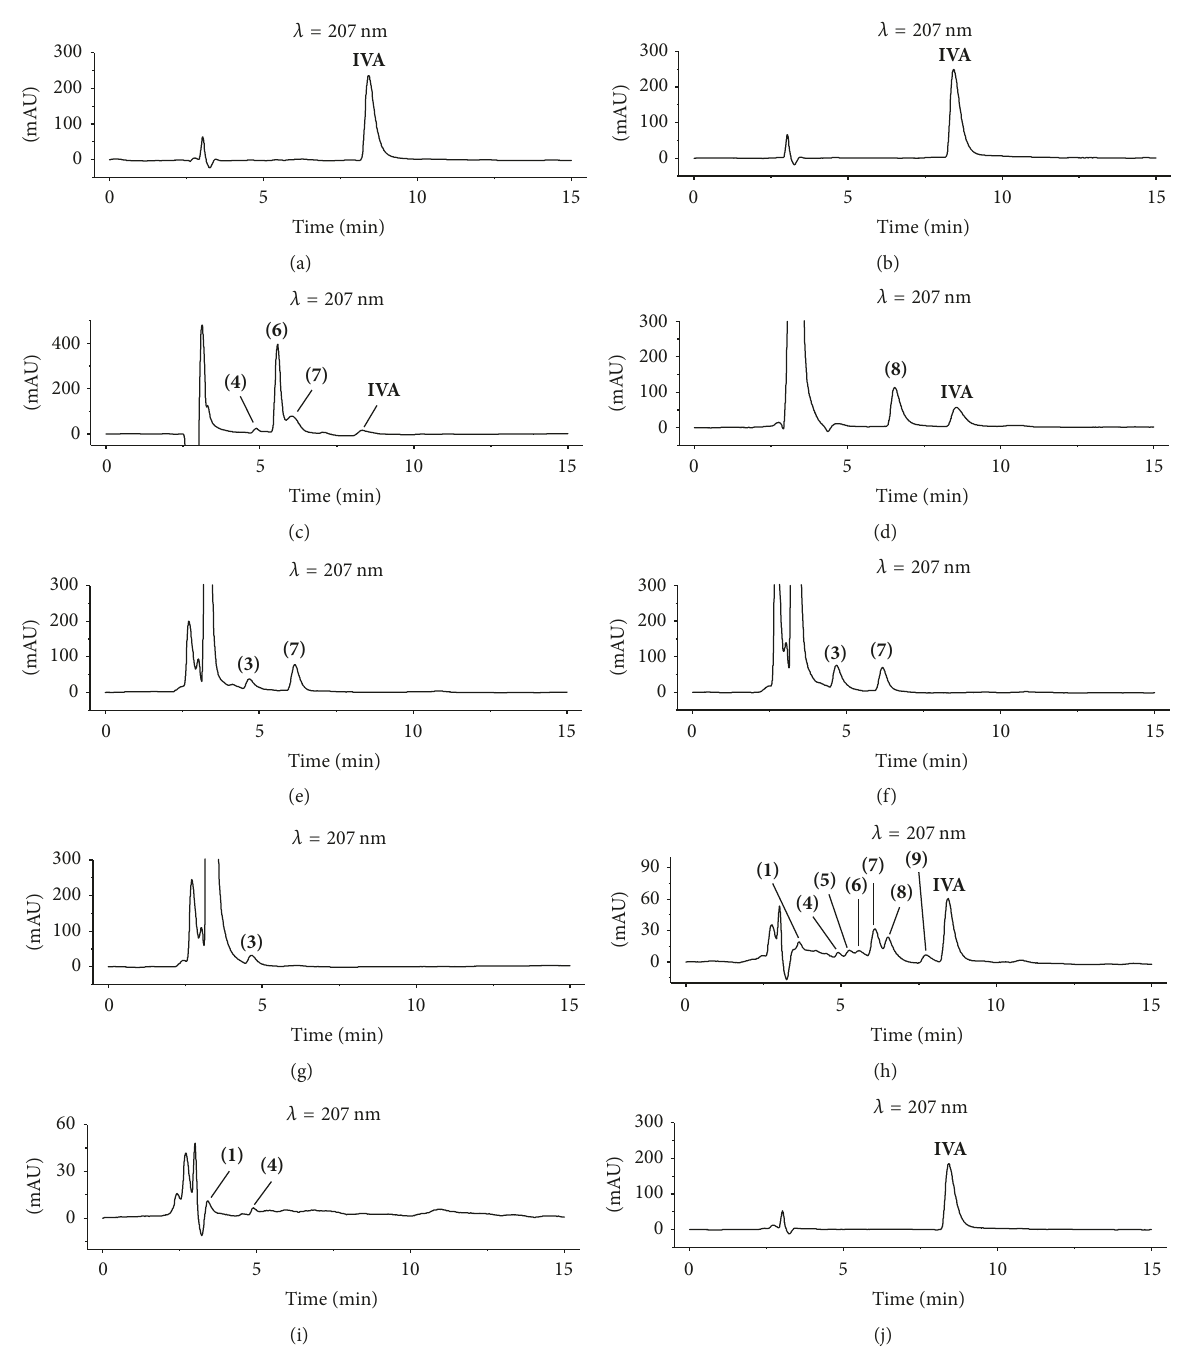
Figure 3: Chromatographic set showing degradation products generated in various conditions at 207 nm: (a) thermal degradation (solution), (b) thermal degradation (powder), (c) acid degradation, (d) alkaline degradation, (e) oxidation (3% H 2 O 2 ), (f) oxidation (7.5% H 2 O 2 ), (g) oxidation (15% H 2 O 2 ), (h) photolysis (24h), (i) photolysis (48h), and (j) photolysis (powder, 120 h).